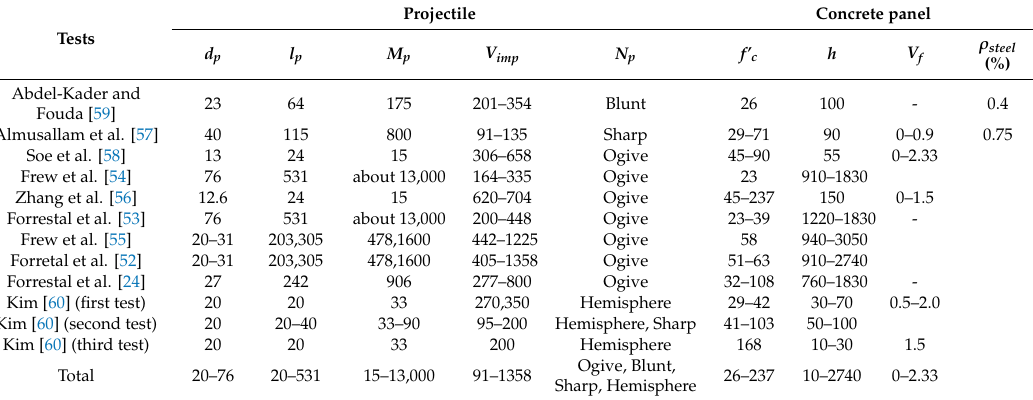
Table 1. Summary of impact test